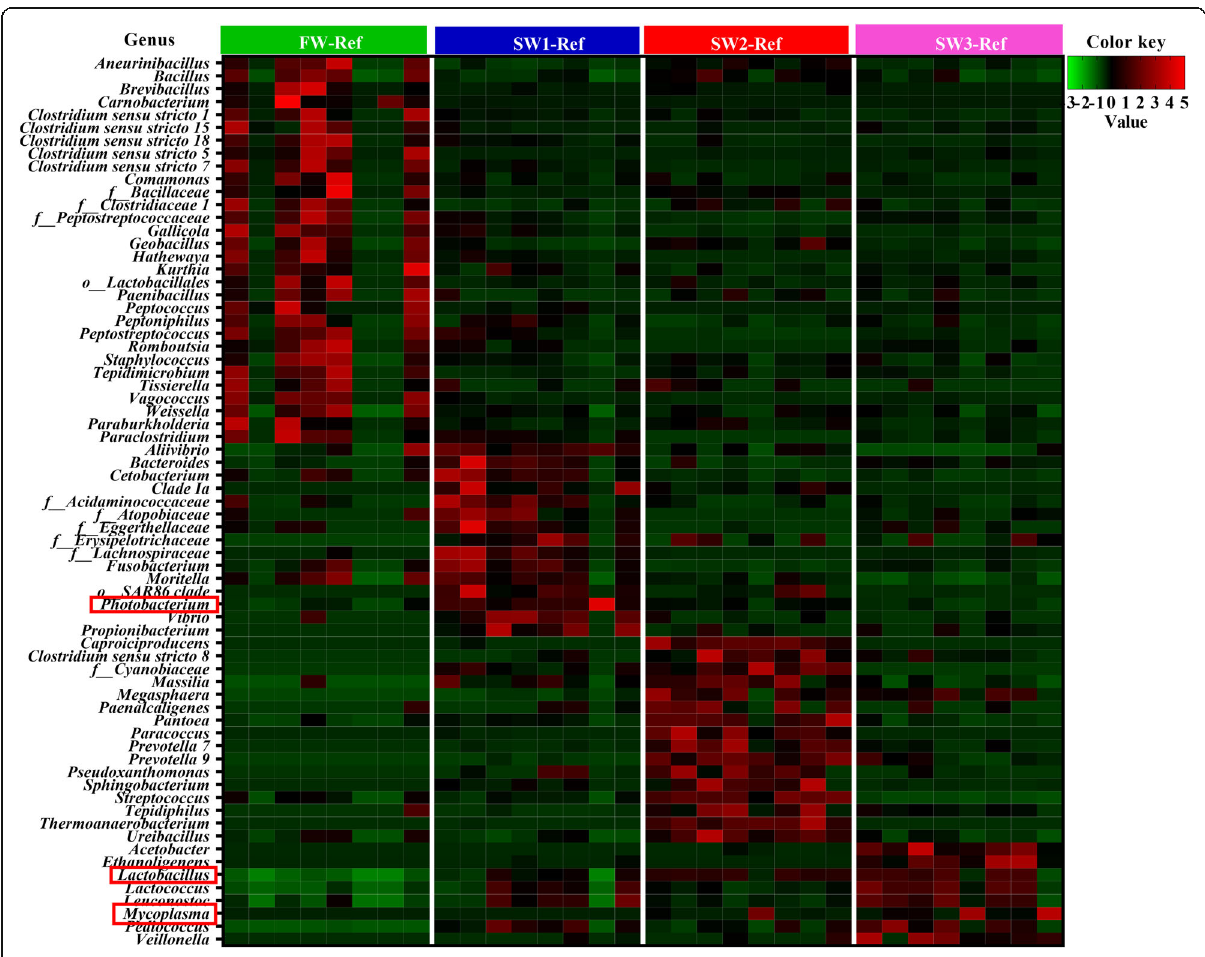
Fig. 3 Heatmap of bacterial abundance in fish fed the Ref diets based on MaAsLin 2 analysis. Rows indicate results for 69 bacteria at genus level ( q-value < 0.05), columns depict the results for the 8 samples at each of the four sampling time points. Color differences indicate differences in normalized relative abundances at genus level, i.e., red (high positive value) indicates the maximum relative abundance; Green (low negative value) indicates the minimum relative abundance. o__: order; f__: